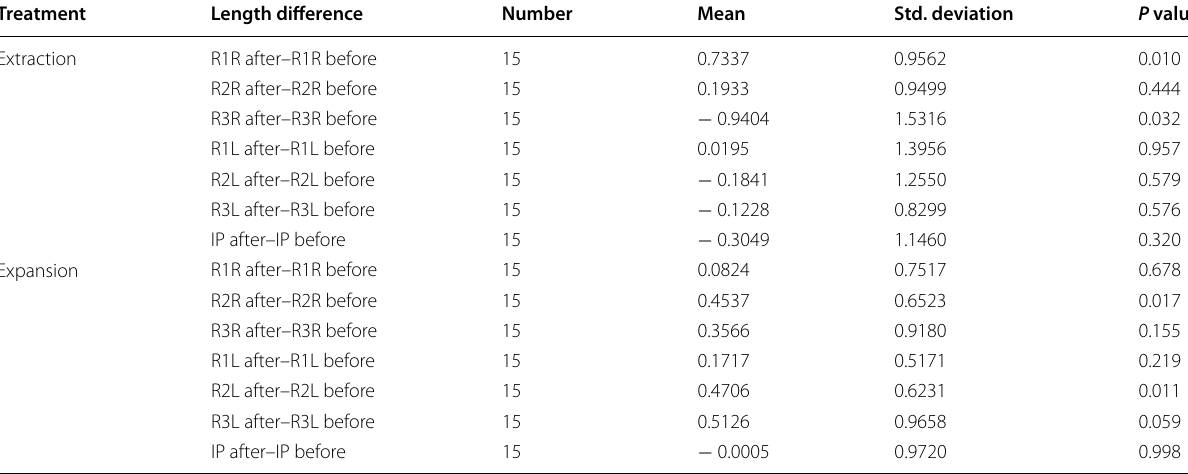
Table 1 Comparison of changes in rugae ridge length (mm) after orthodontic treatment